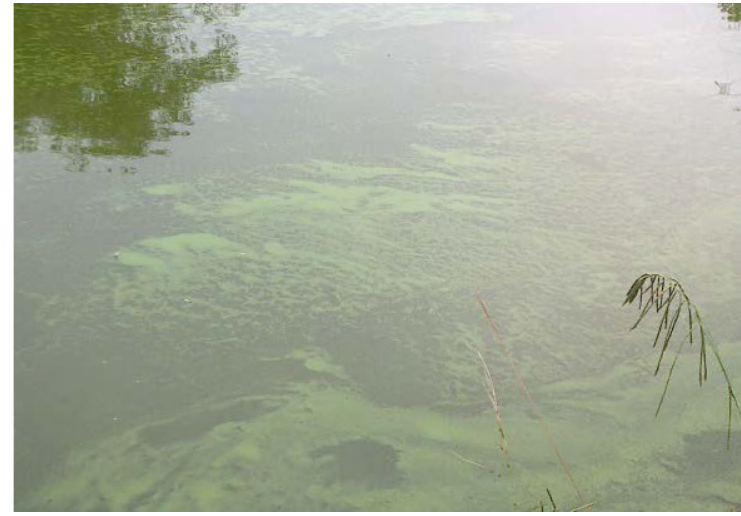
Figure 1. Photograph of a CyanoBloom ( Microcystis sp.) in a river in the North of Portugal.